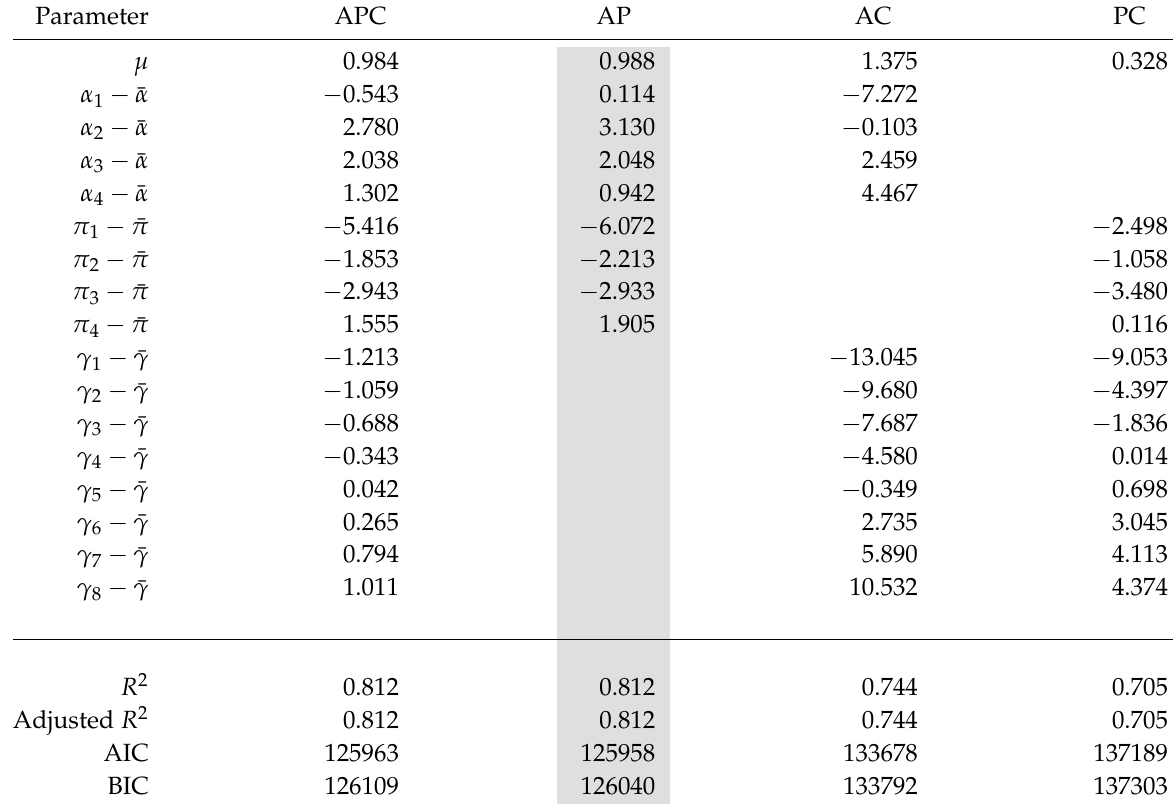
Last and two-factor models.